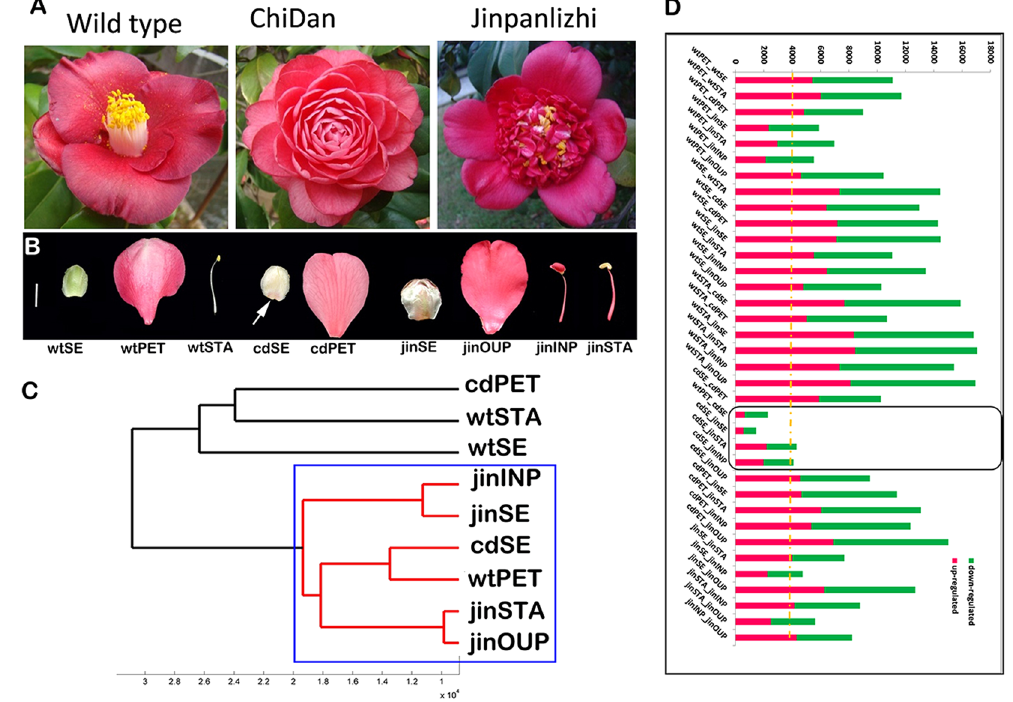
Figure 1. Comparative transcriptomics analysis in wild and doubled camellias. ( A ) Overviews of wild and double flower varieties. From left to right, wild, formal double “ChiDan”, anemone double “Jinpanlizhi”. ( B ) Floral tissues for the transcriptomics study. Arrow indicates the pigmentation in sepal of ChiDan. White bar, = 1 cm. ( A , C ) dendrogram plot of clustering of samples by the mean expression levels. Distance less than 20,000 was highlighted by red lines (inside the blue rectangular). ( D ) The summary of numbers of DEGs among floral organs. Red, up-regulated genes; green, down-regulated genes. wtSE, wild type sepal; wtPET, wild type petal; wtSTA, wild type stamen; cdSE, ChiDan sepal; cdPET, ChiDan petal; jinSE, Jinpanlizhi sepal; jinOUP, Jinpanlizhi outer petal; jinINP, Jinpanlizhi inner petal; jinSTA, Jinpanlizhi